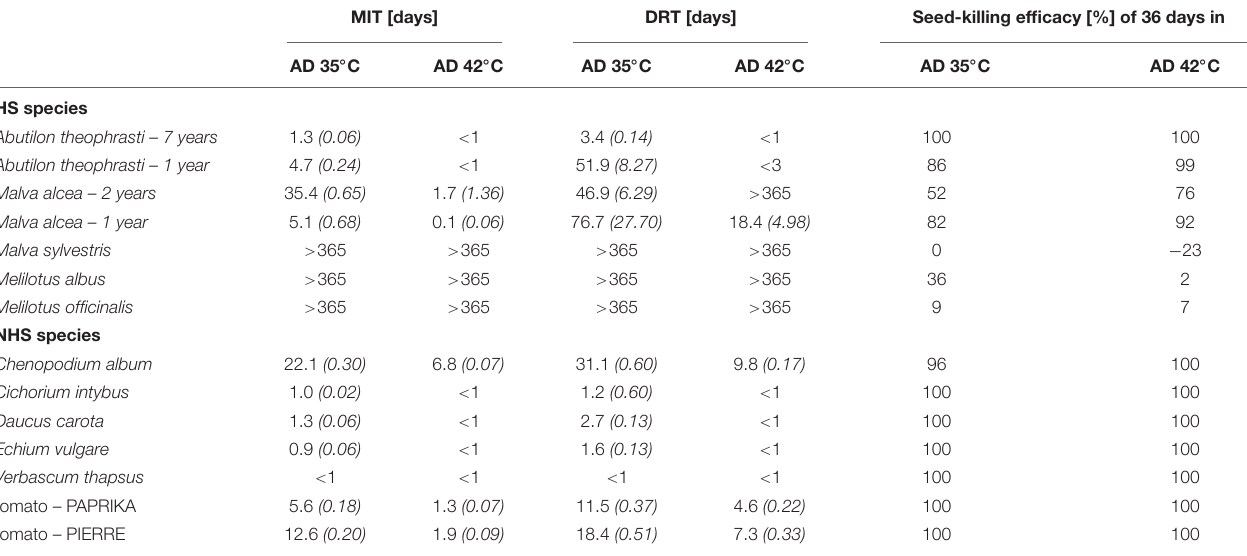
TABLE 1 | Estimated median inactivation times (MITs) and decimal reduction times (DRTs) of seeds of flowering wild plant species and tomato after anaerobic digestion (AD) at 35 or 42 ◦ C in lab-scale reactors, and corresponding seed-killing efficacy of AD. MIT